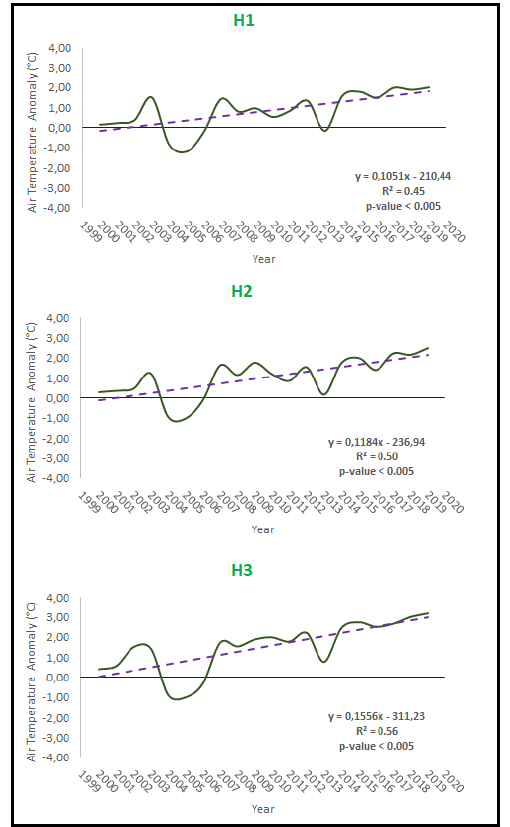
Figure 6. Yearly anomaly of air temperature in the period from 2000–2019 (annual mean temperature).